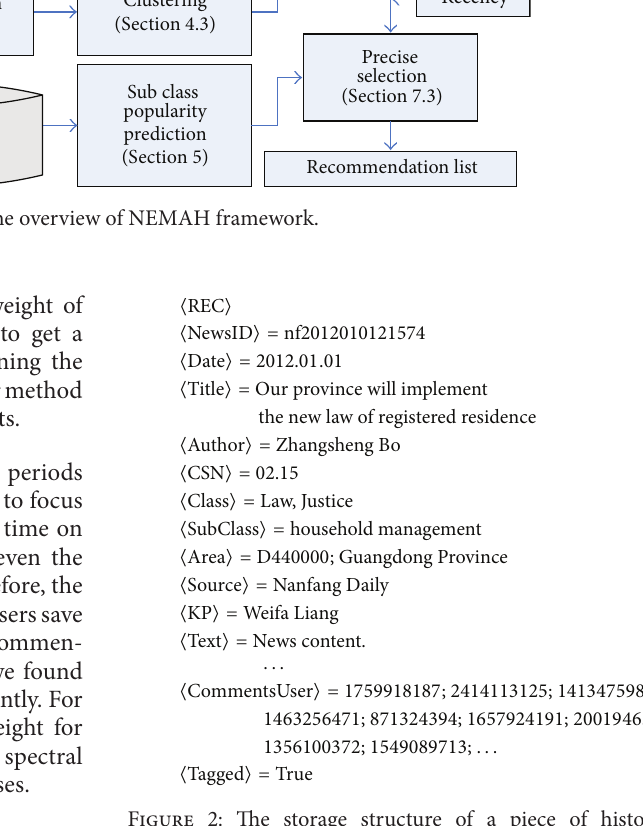
Figure 2: The storage structure of a piece of history